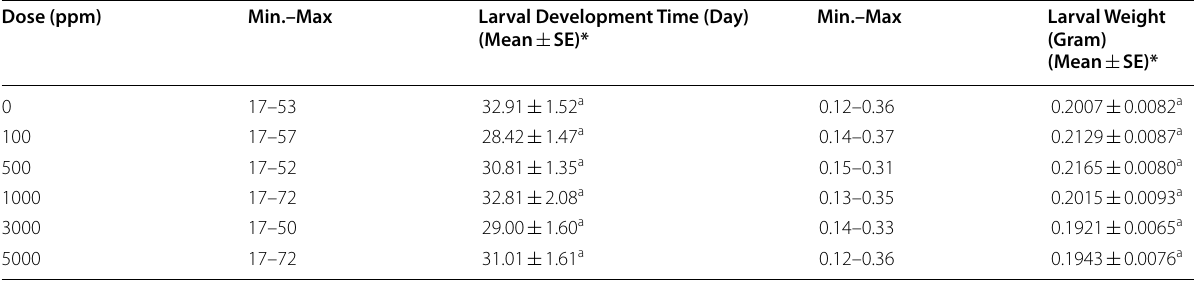
*Kruskal Wallis, P > 0.05